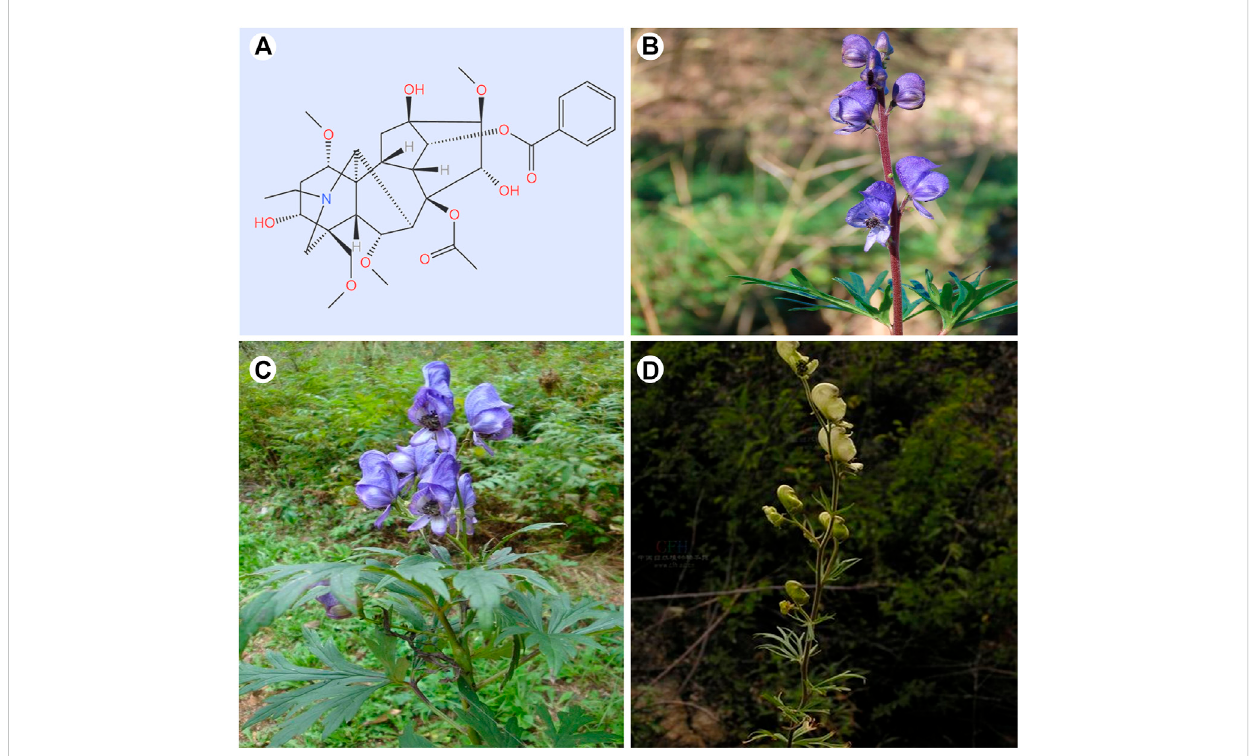
FIGURE 2 Structuralformulaofaconitineandbotanicaldiagramofsomemajor Aconitum sourcespecies. (A) ThestructuralformulaofAconitine. (B) Aconitum carmichaelii Debeaux.(Wutou). (C) Aconitumbrachypodum Diels.(Xueshangyizhihao). (D) Aconitumcoreanum (H.Lév.)Raipaics.(Huanghuawutou).The representative photos of the three Aconitum species are from the website: https://www.gbif.org/;